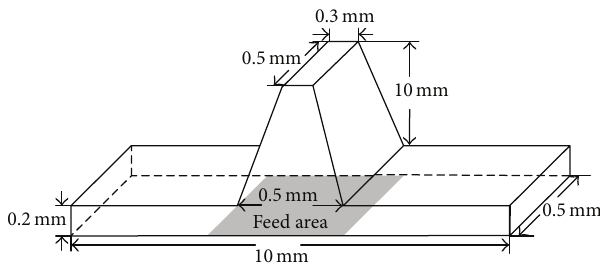
Figure 10: The antenna structure for fabrication.